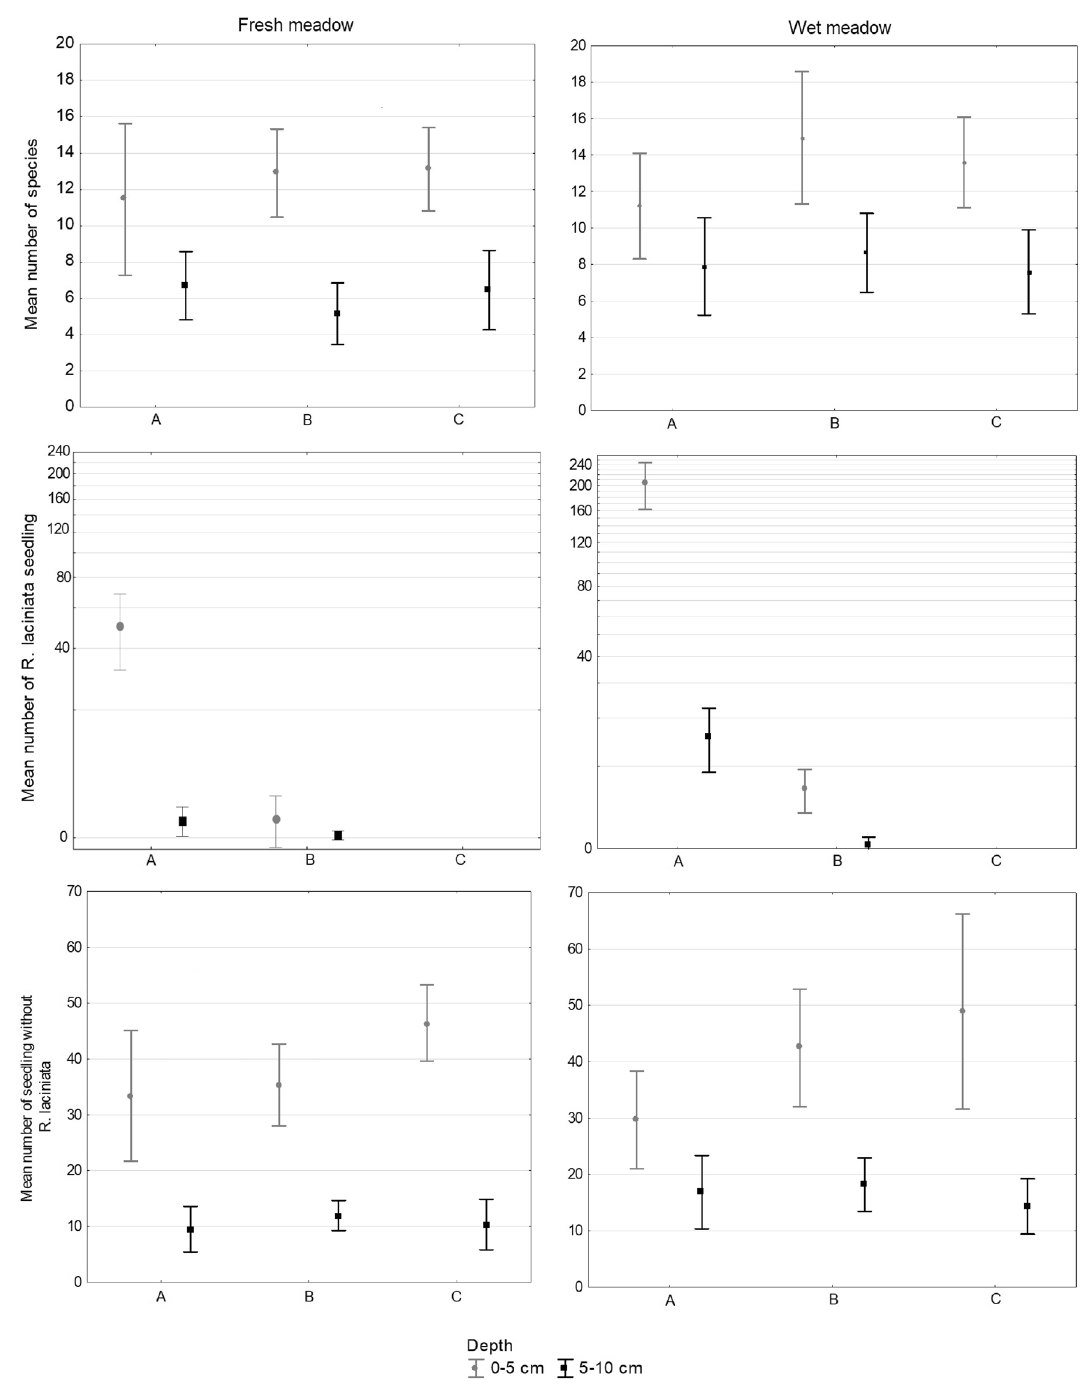
Figure 2. Mean number of species and seedlings with the standard deviation in each zones (A—invasion, B— transition, C—control) and depth layer (grey: 0–5 cm; black: 5–10 cm) in two types of